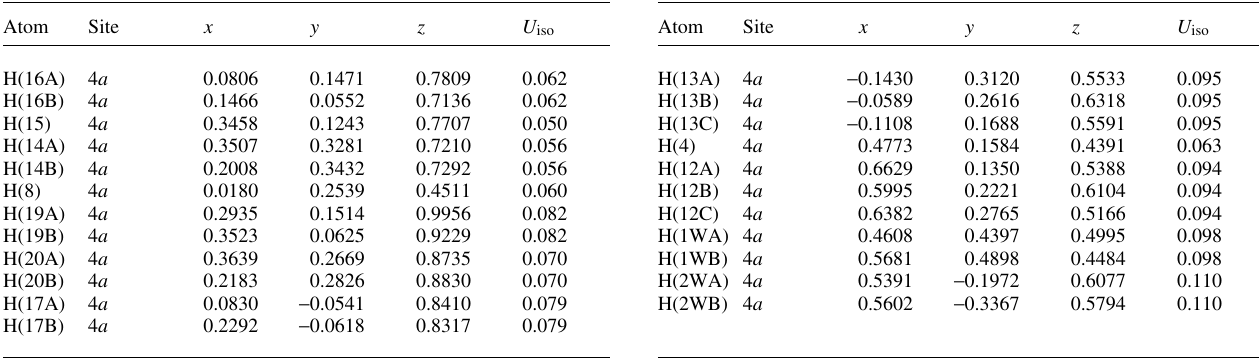
Table 2. Atomic coordinates and displacement parameters (in Å 2 )